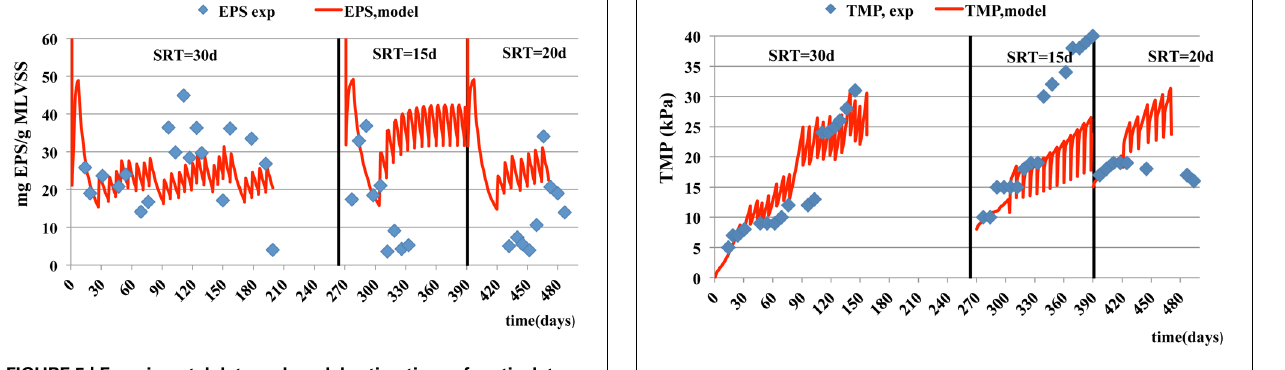
FIGURE 8 | Experimental data and model estimations of trans-membrane pressure vs. time at three different